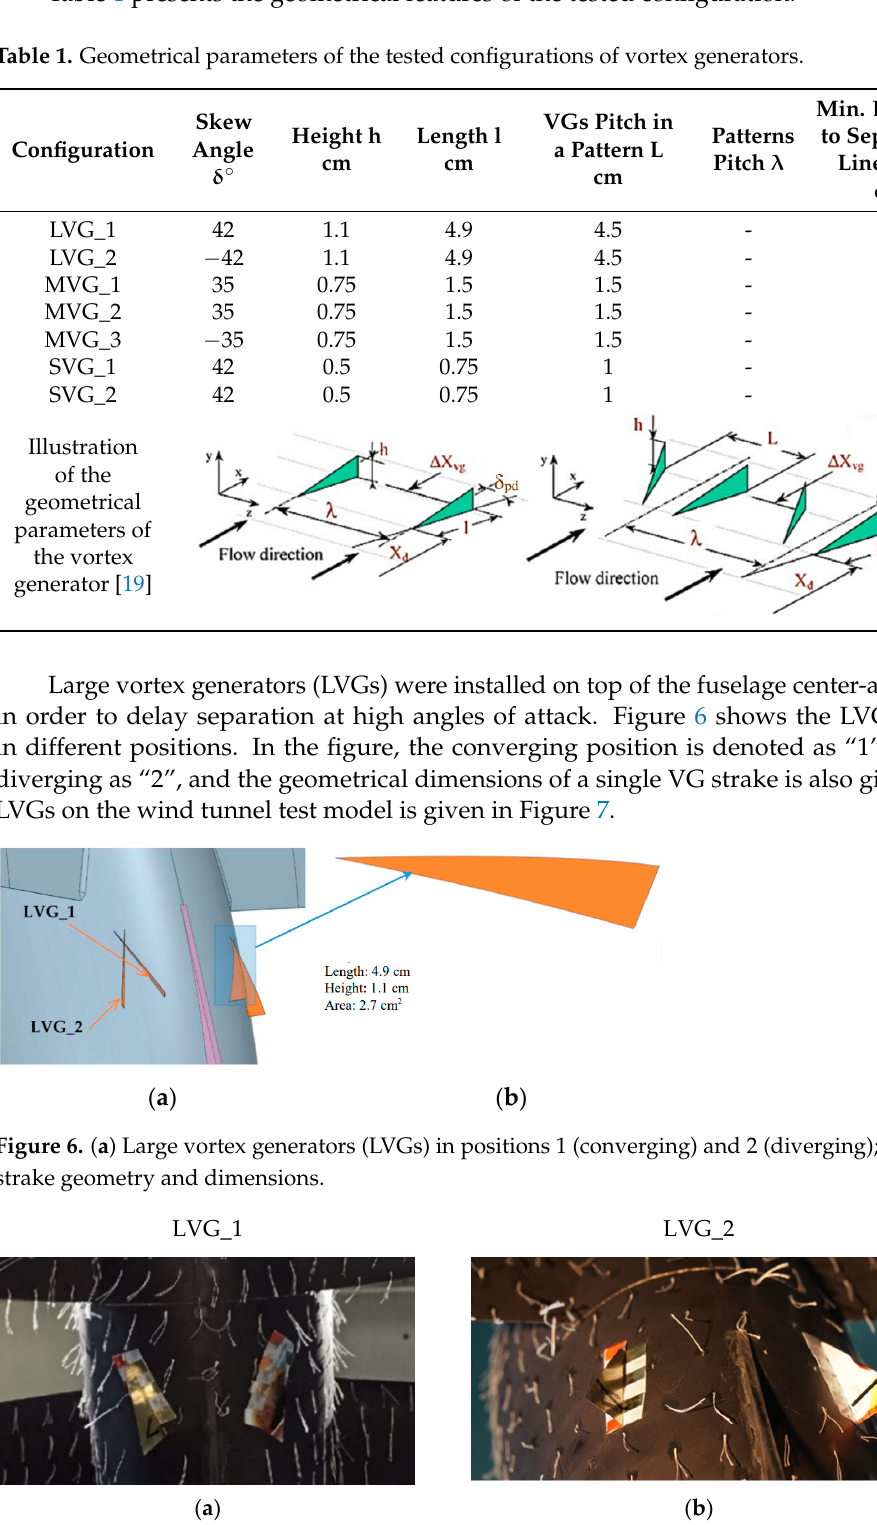
Figure 7. Large vortex generators (LVGs) in positions: ( a ) “1” and ( b ) “2” on the wind tunnel model.